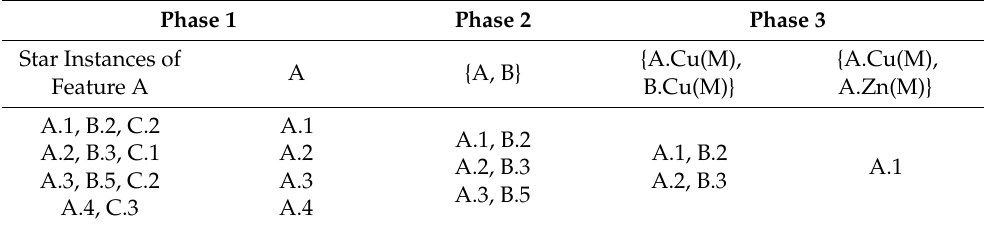
Table 5. An example of the extended Joinless algorithm. Phase 1 Phase 2 Phase 3 Star Instances of A {A, Feature A